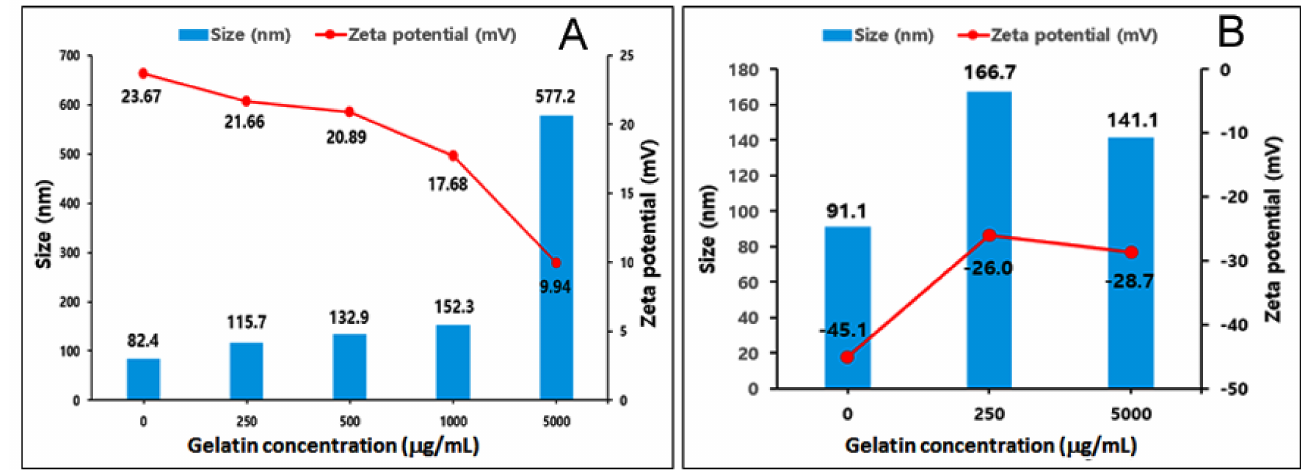
Figure 3. Size and zeta potential of GCL-1 ( A ) and GCL-2 ( B ) according to gelatin